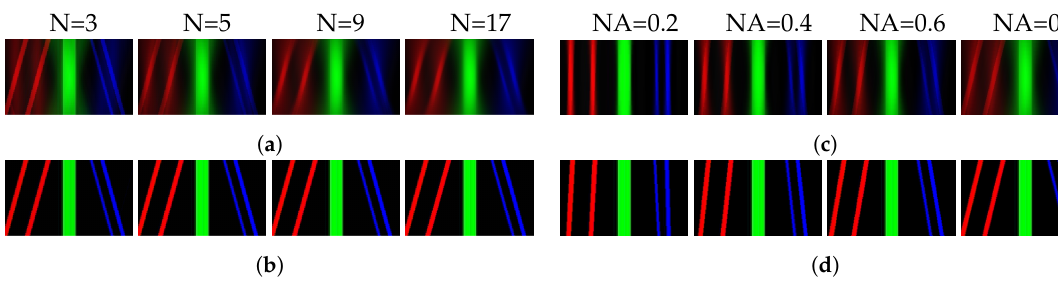
Figure 9. The reconstructed EPIs calculated from various number of depth images ( a , b ) and five depth images captured under various camera numerical apertures (NA) ( c , d ), by the conventional LFBP I ( a , c ) and denoised LFBP II ( b , d ), respectively, adapted with permission from [51], Optical Society of